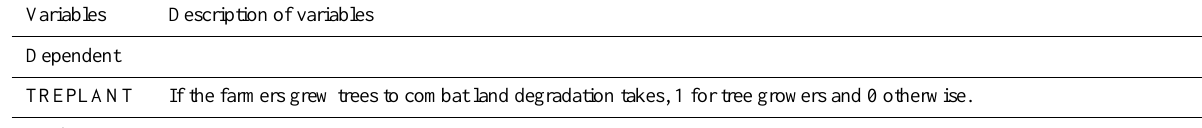
Table 2. Definition of variables used in the